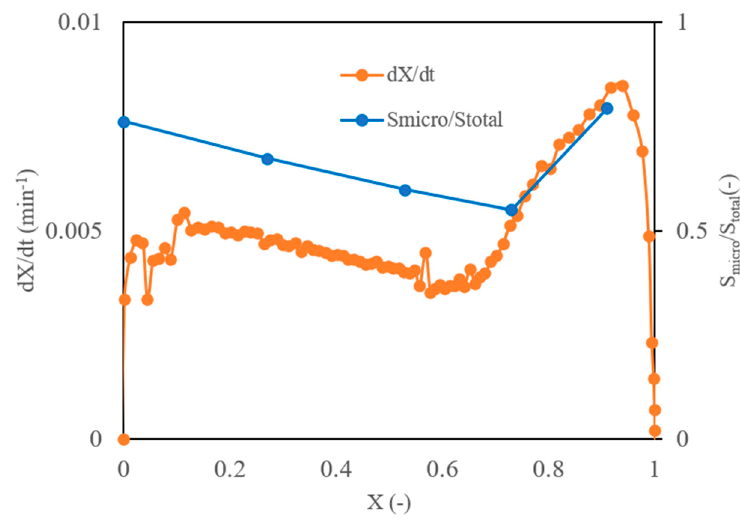
Figure 3. Micropores development and its reactivity at 750 °C.